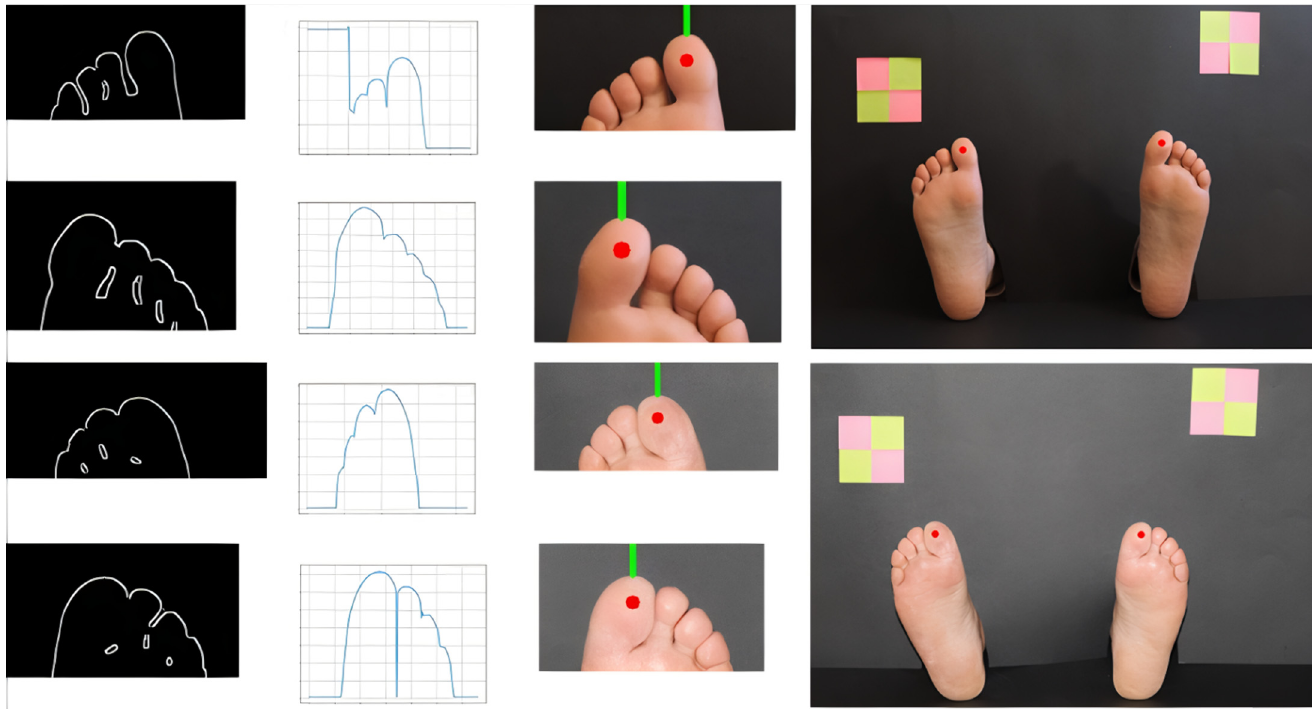
Figure 5. Examples of hallux segmentation and testing site identification. First column shows the foot edges obtained from the background segmentation stage after extraction of the region of interest; second column shows the projected contour values; third column shows the peak contour value and the testing site; forth column shows the testing site remapped on the original image.